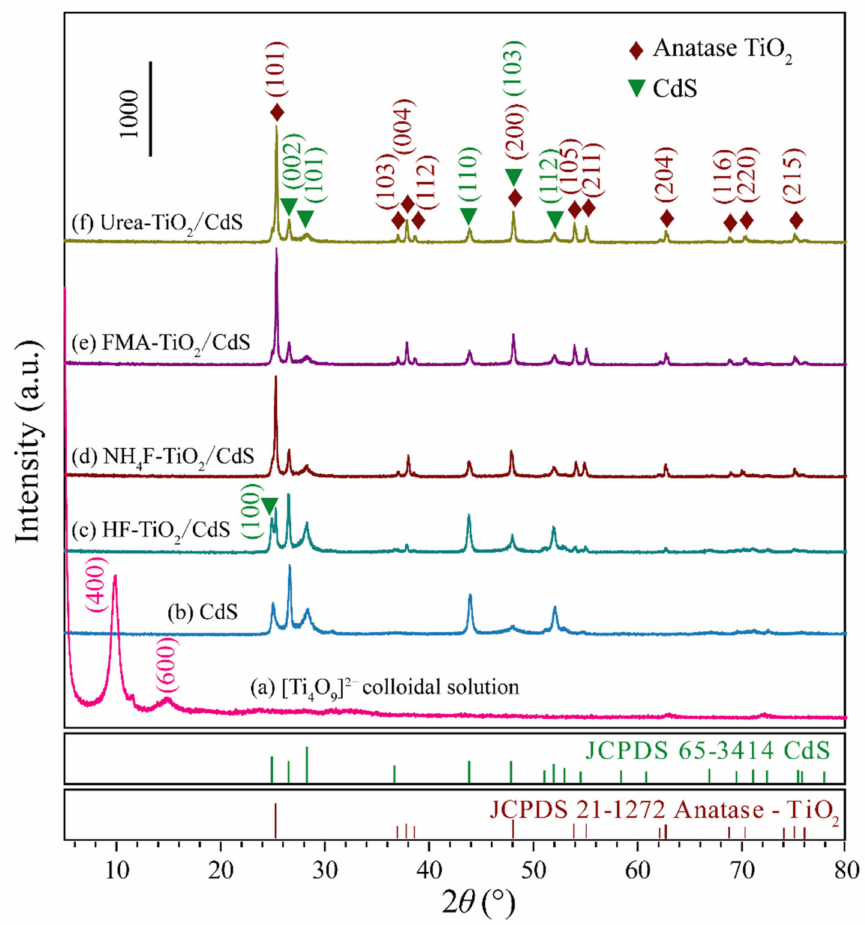
Figure 2. XRD patterns of as-prepared ( a ) [Ti 4 O 9 ] 2 − colloidal solution, ( b ) CdS, ( c ) HF-TiO 2 /CdS, ( d ) NH 4 F-TiO 2 /CdS, ( e ) FMA-TiO 2 /CdS, and ( f ) Urea-TiO 2 /CdS